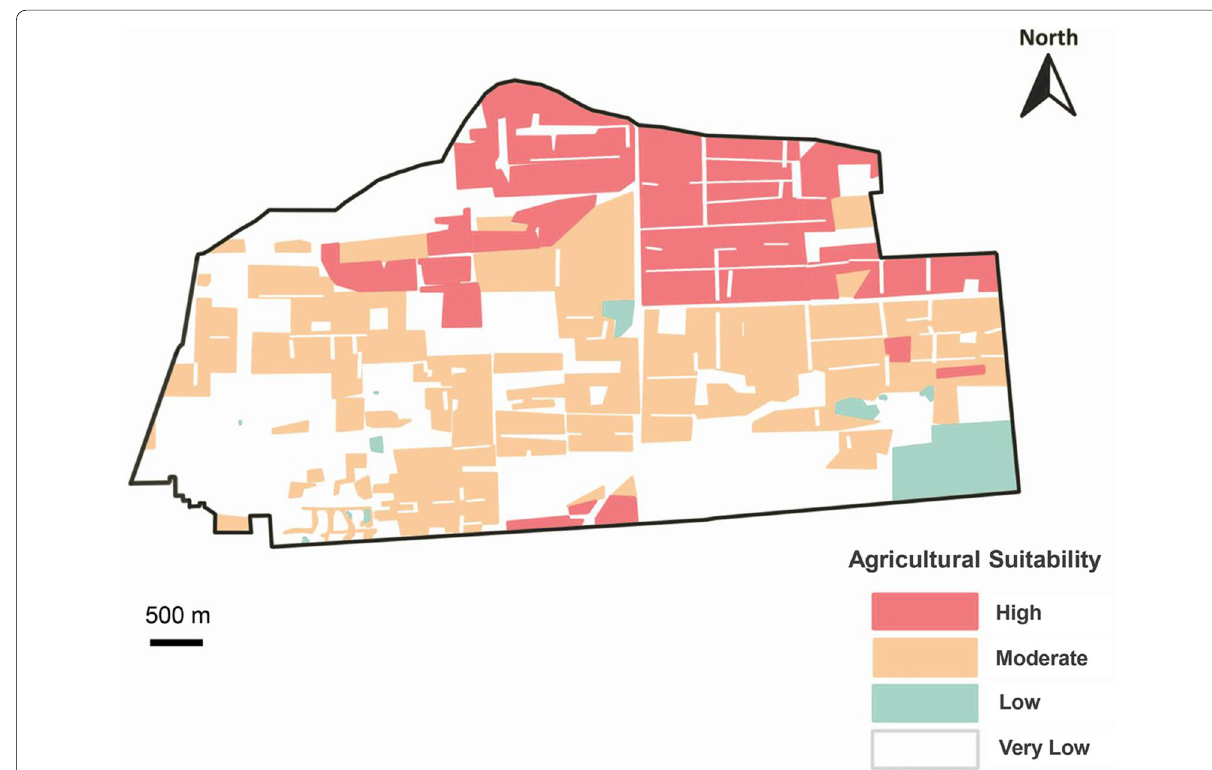
Fig. 5 Map showing the distributions of lands, where the suitability of rehabilitation is high (red), moderate (orange), low (green), and very low